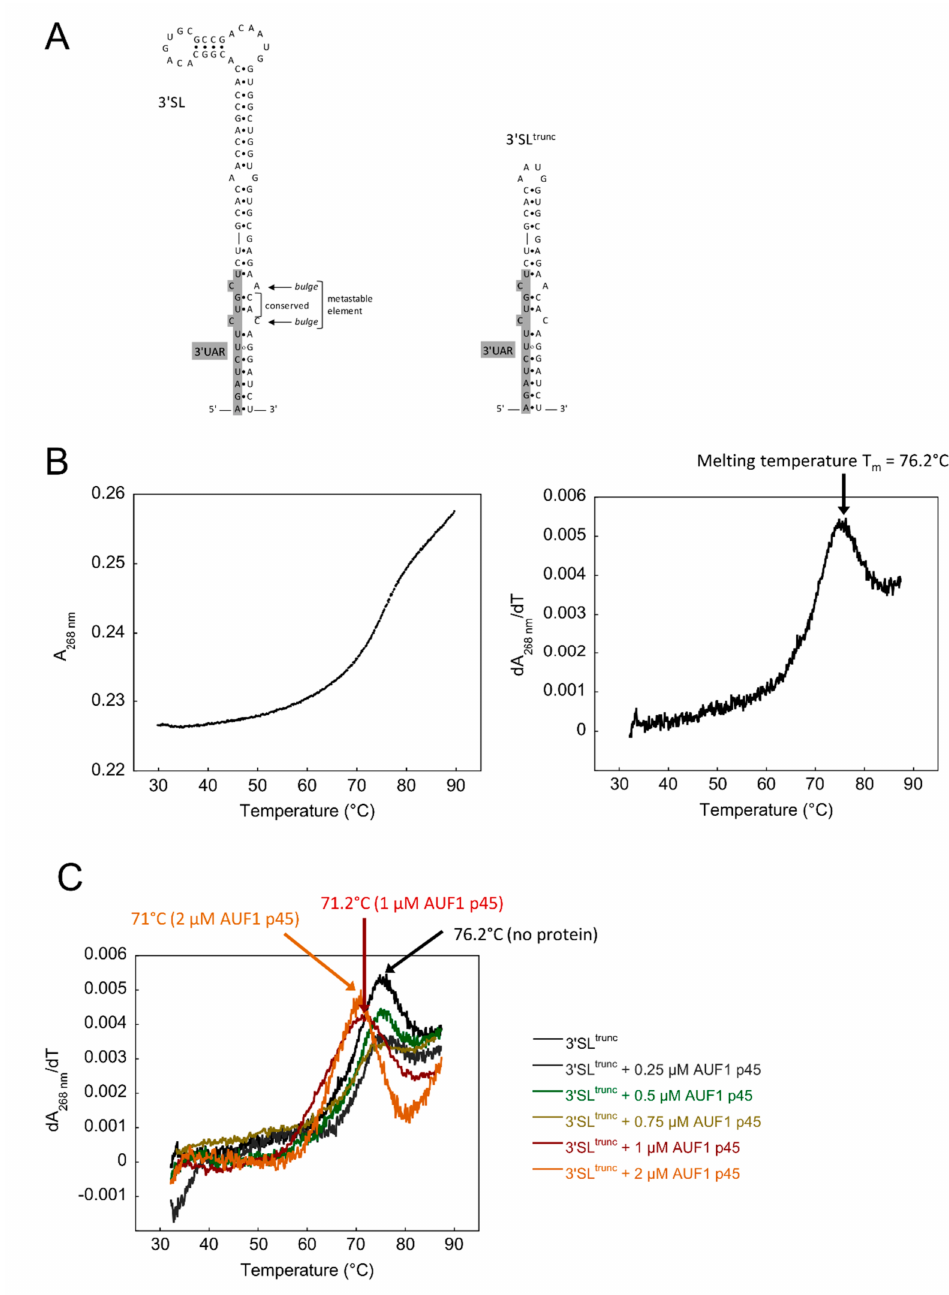
Figure 1. AUF1 p45 increases the flexibility of the WNV 3 (cid:48) SL. ( A ) Sequence and secondary structure of the full-length WNV 3 (cid:48) SL (left) and a truncated 3 (cid:48) SL (3 (cid:48) SL trunc ) that was used for the thermal denaturation experiments (right). The 3 (cid:48) UAR cyclization sequence is shown in grey. The metastable element within the bottom part of the 3 (cid:48) SL consists of two conserved base pairs and is flanked by two bulges. ( B ) (left) Thermal denaturation of the 3 (cid:48) SL trunc RNA. The denaturation was recorded in the temperature range from 30 to 90 ◦ C. (right) First derivative of the trace shown on the left to determine the melting temperature T M (arrow). ( C ) First derivatives of thermal denaturation experiments of the 3 (cid:48) SL trunc RNA in the absence and presence of increasing concentrations of AUF1 p45. Melting temperatures are indicated with